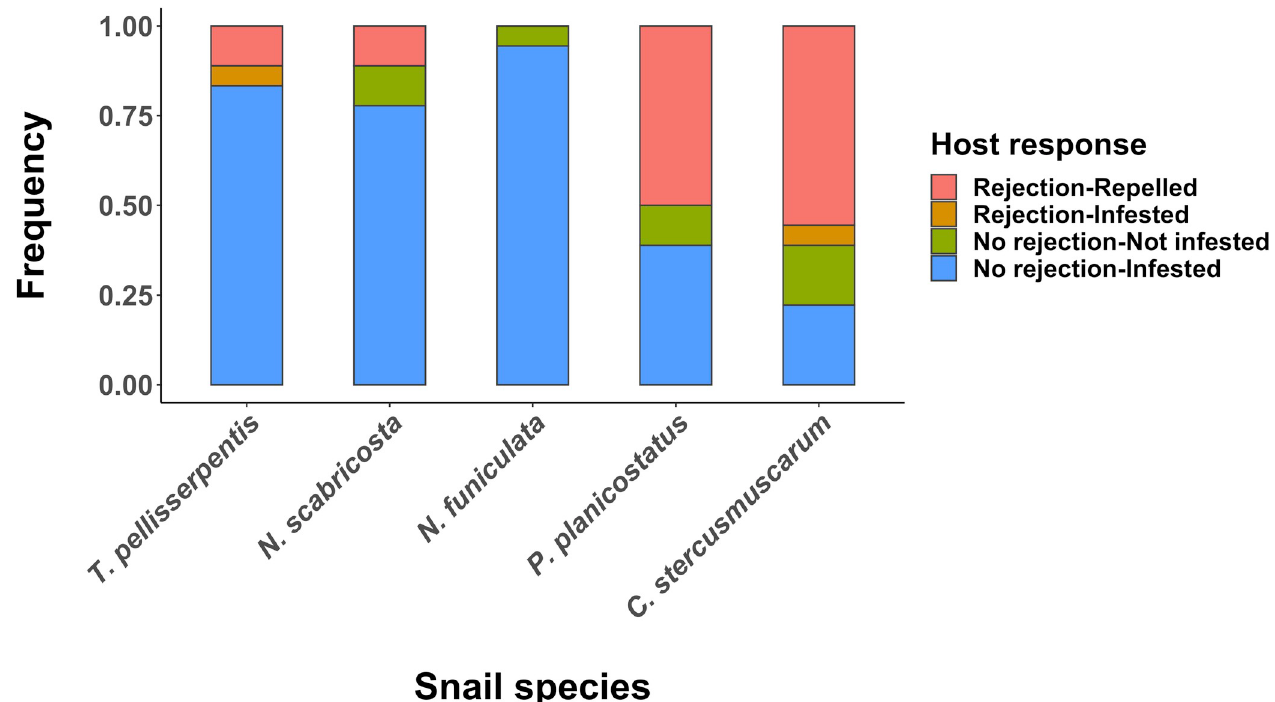
Fig 3. Host rejection behaviors and flatworm infestation success. Frequencies of different snail and flatworm responses during experimental infestation. The responses were classified as: the host rejects and repels the worm (red pink), the host rejects the worm, but the worm successfully infests the host (orange), the host does not reject the worm, but the worm does not infest the host (olive green), and the host does not reject the worm, and the worm successfully infests the host (light blue). Snail and flatworm responses were tracked over the allotted time period of 3 minutes using 18 different individuals for each species.